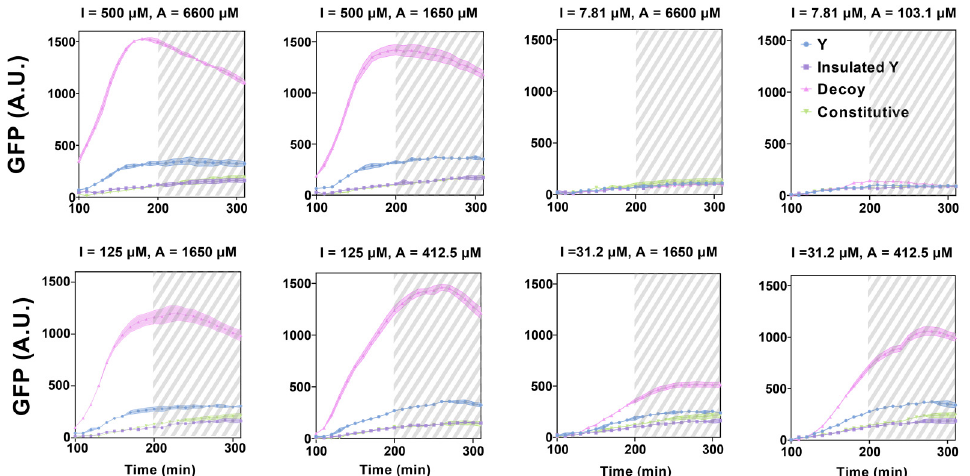
Figure 3. In vivo characterization of the RNA-only IFFL circuit composed of STAR and 3WJ repressor. Time course of GFP fluorescence measurements for different inducer concentrations; IPTG concentrations at 500 µ M, 125 µ M, 31.2 µ M and 7.81 µ M; Arabinose concentrations at 6600 µ M, 1650 µ M, 412.5 µ M and 103.125 µ M. Data for the first 90 min are removed due to low OD600 values, and the time points beyond 200 min are marked as gray dashed area to indicate the transition to stationary phase. Regular Y is represented by blue circles, insulated Y by purple squares, Decoy by pink triangles, and constitutive by green triangles. The letters ‘I’ and ‘A’ represent IPTG and Arabinose, respectively. Relative errors for GFP fluorescence are from the standard deviation of three biological replicates.